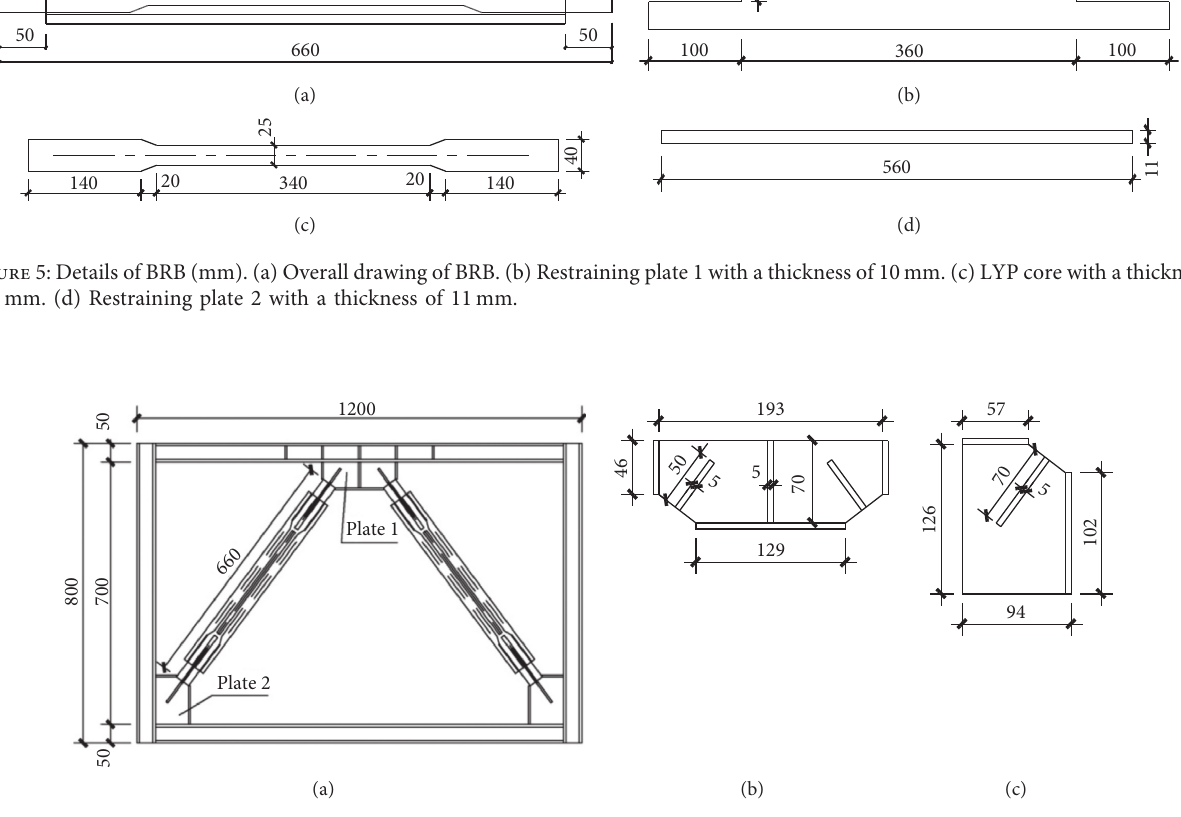
Figure 6: Detailed connection of BRB (mm). (a) Connection of BRB. (b) Gusset plate 1. (c) Gusset plate